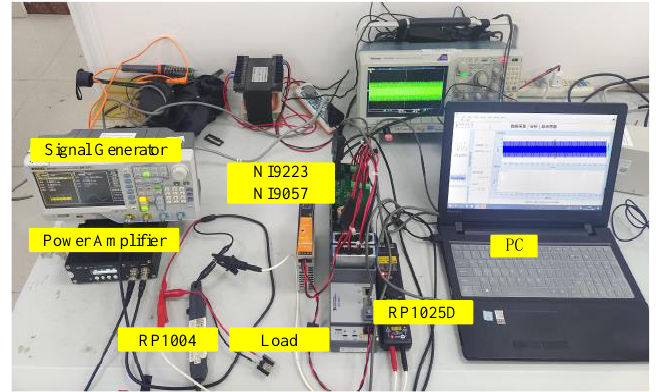
Figure 5. Class D signal test settings.